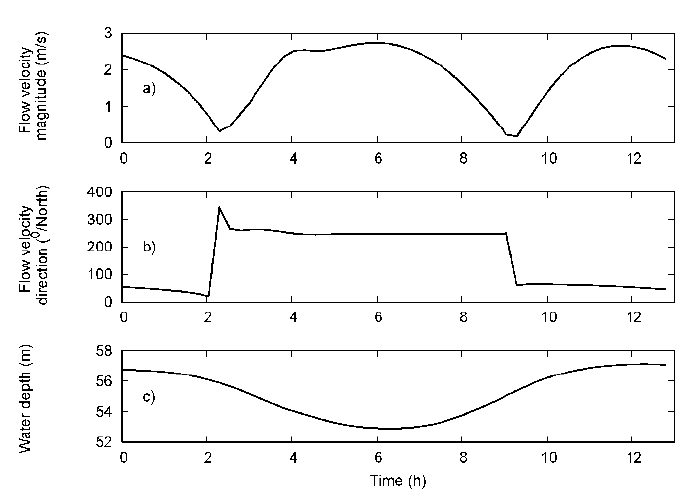
Figure 6. Temporal evolution of the flow velocity magnitude ( a ), flow velocity direction ( b ), and water depth ( c ) over a mean tide. The flow directions are expressed following the nautical convention. Table 2. Boundary conditions calculated with the regional model (Figure 7). The angle is expressed in nautical convention. The incidence is given with respect to the optimal flow direction (the x axis of the local model frame). Number of the Simulation Time (h) U in (m / s) Angle (deg) Incidence (deg) 1